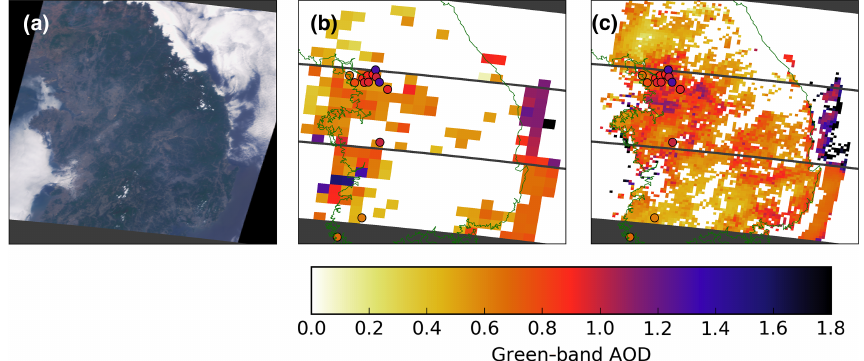
Figure 6. (a) The MISR true-color (RGB) image of the Korean peninsula on 9 May 2012 at around 02:20UTC; (b) MISR V22 17.6km aerosol optical depth (AOD); (c) MISR 4.4km AOD retrieved using the prototype algorithm.